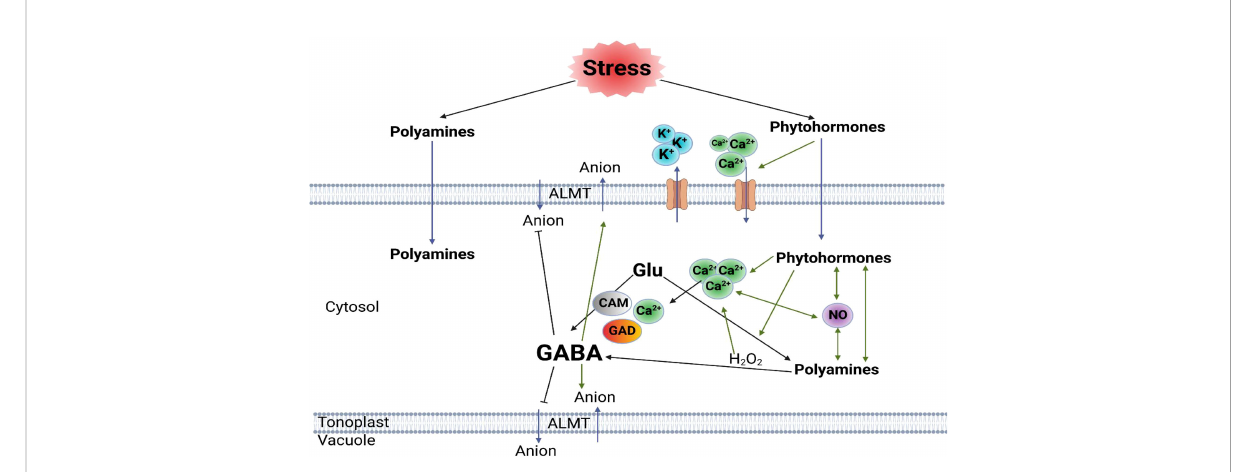
FIGURE 2 Diagrammatic model of plant stress responses mediated by hormones, polyamines and GABA in different plant cell types, including guard cells and root cells based on Bown and Shelp (2016). Continuous black arrows indicate metabolic pathways; green arrows indicate regulation process; and blue arrows indicate transportation. Glu; L-glutamate, GABA; g -aminobutyric acid, ALMT; aluminium-activated malate transporter, CAM; calmodulin, GAD; glutamate decarboxylase. (Marco et al., 2011; Choi et al., 2016; Podles ̌ a ́ kova ́ et al.,